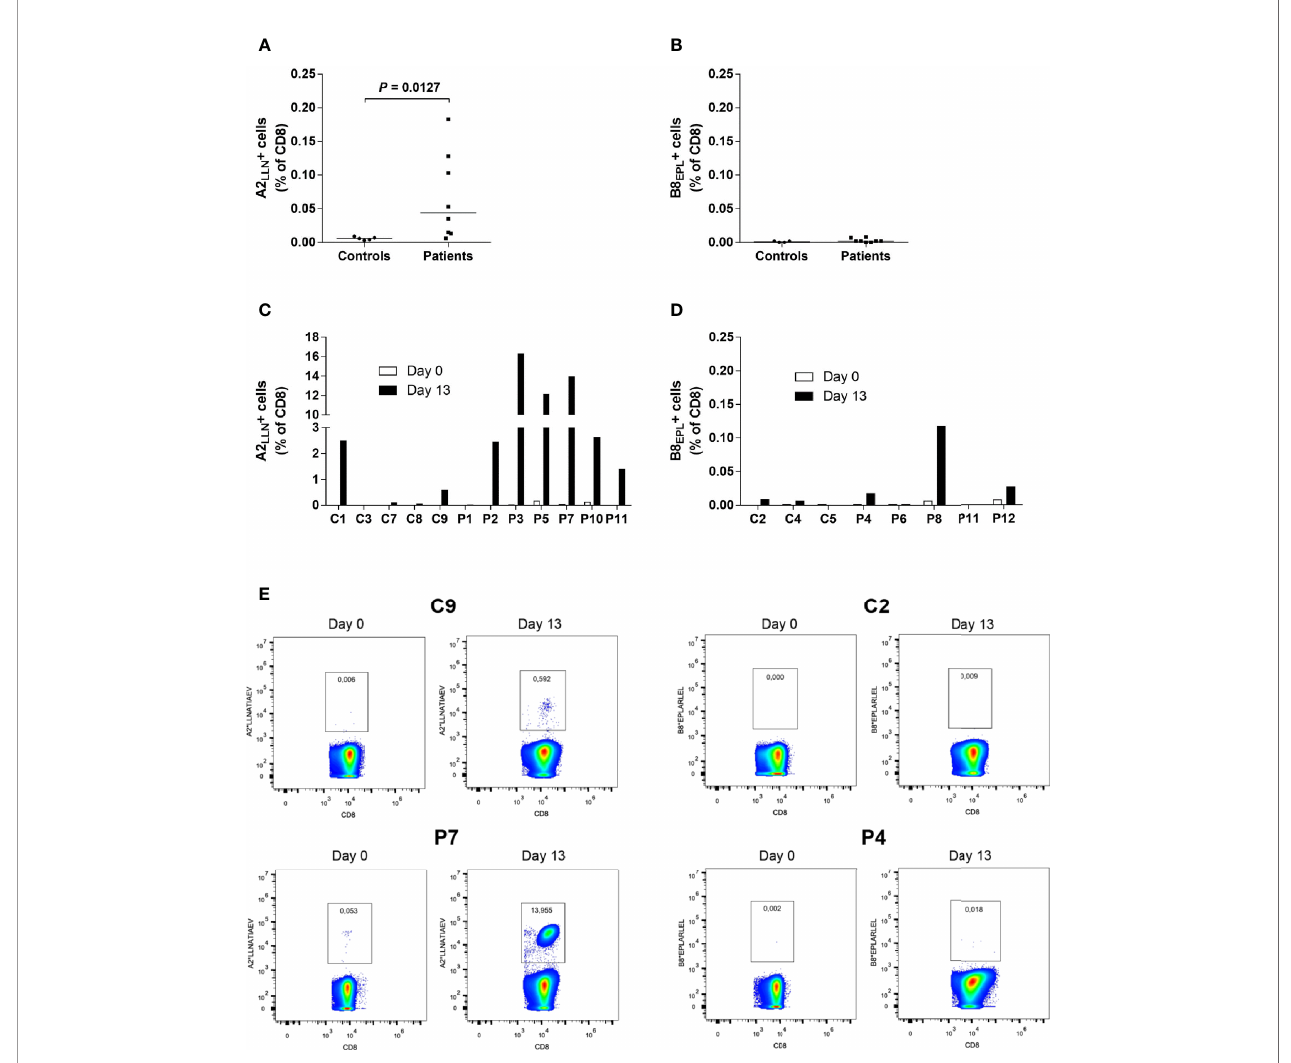
FIGURE 1 | Increased frequencies of LLNATIAEV-speci fi c CD8+T cells in AAD patients. (A) PBMCs from HLA-A2 positive AAD patients (n = 8) and controls (n = 5) were stained with A2*LLNATIAEV dextramers ex vivo and analyzed with fl ow cytometry. (B) PBMCs from HLA-B8 positive AAD patients (n = 8) and controls (n = 4) were stained with B8*EPLARLEL dextramers ex vivo and analyzed with fl ow cytometry. (C) PBMCs from HLA-A2 AAD patients (n = 7) and controls (n = 5) were stained with A2*LLNATIAEV dextramers following 13 days of peptide-induced in vitro expansion and analyzed with fl ow cytometry. Differences were not statistically signi fi cant. (D) PBMCs from HLA-B8 AAD patients (n = 5) and controls (n = 3) were stained with B8*EPLARLEL dextramers following 13 days of peptide-induced in vitro expansion and analyzed with fl ow cytometry. The graphs (A – D) show the frequencies of dextramer-binding CD8+ T cells. Lines (A, B) represent median values. Statistical analyses were performed using Mann-Whitney U-test; P-values <0.05 are shown. (E) Representative fl ow cytometry dextramer plots from two HLA-A2 (C9, P7) and two HLA-B8 (C2, P4) individuals ex vivo and following expansion (day 13). A strict, fi xed gate was used to distinguish dextramer-positive from negative cells. Gate numbers represent the frequencies (percentage) of dextramer-positive cells among total CD8+ T cells.